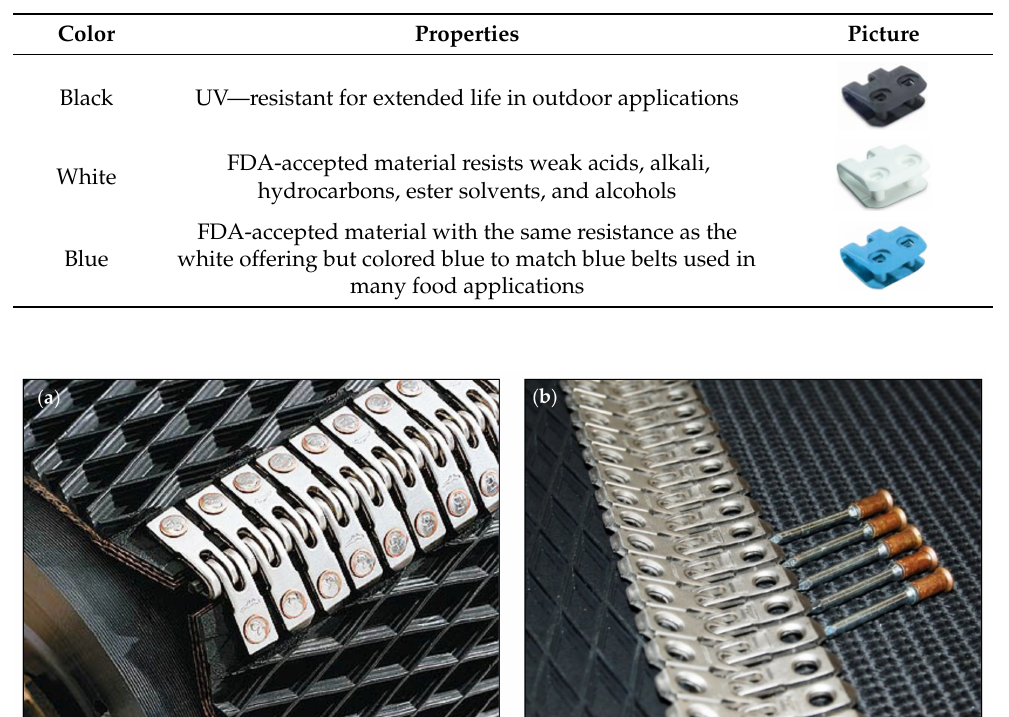
Figure 11. Plastic rivet fastening: general view [25]. Table 3. Material variants of the plastic rivets fastening [25].